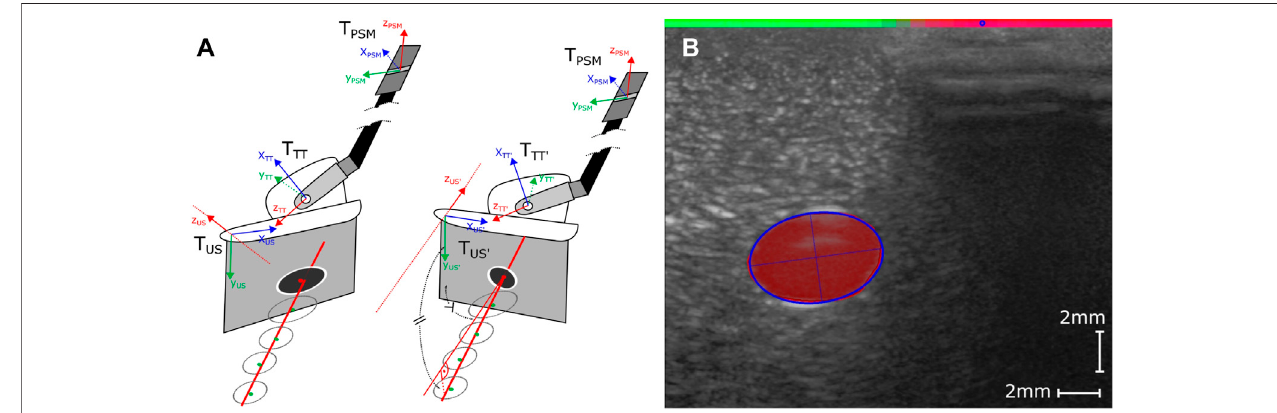
FIGURE 3 | (A) Considered coordinate Frames T US , T TT and T PSM Left: Before adaption of the image plane normal (poor orientation T US and T TT ), Right: After adaption ofimageplanenormal(idealorientation), basedonprojectedvesselcenterline(goodorientation T US ’ and T TT ’ ). (B) Visualrepresentation ofthepost-processed outputsof thetwo Deep NeuralNetworks.The fi tted ellipse (blue outline) closelytracks the segmentation results ofthe U-Net (area inred). The detected coupling quality by the DC-Net is visualized by the colored bar on the top transitioning from green (good coupling) to red (poor coupling) and the blue circle representing the calculated c COM